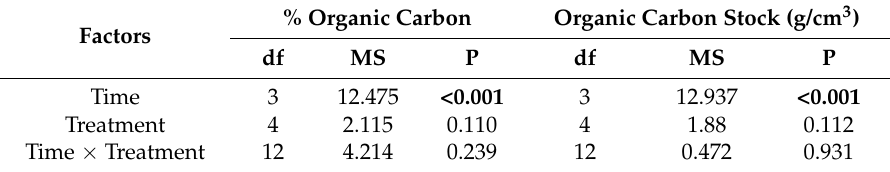
Table 1. Results of ANOVA test on the effects of time (7, 30, 90, 180 days), warming treatment (high, medium, low, control, procedural control), and their interactions on the % organic carbon (Corg) and the organic carbon stock within seagrass cores. Significant p -values (<0.05) down in bold.